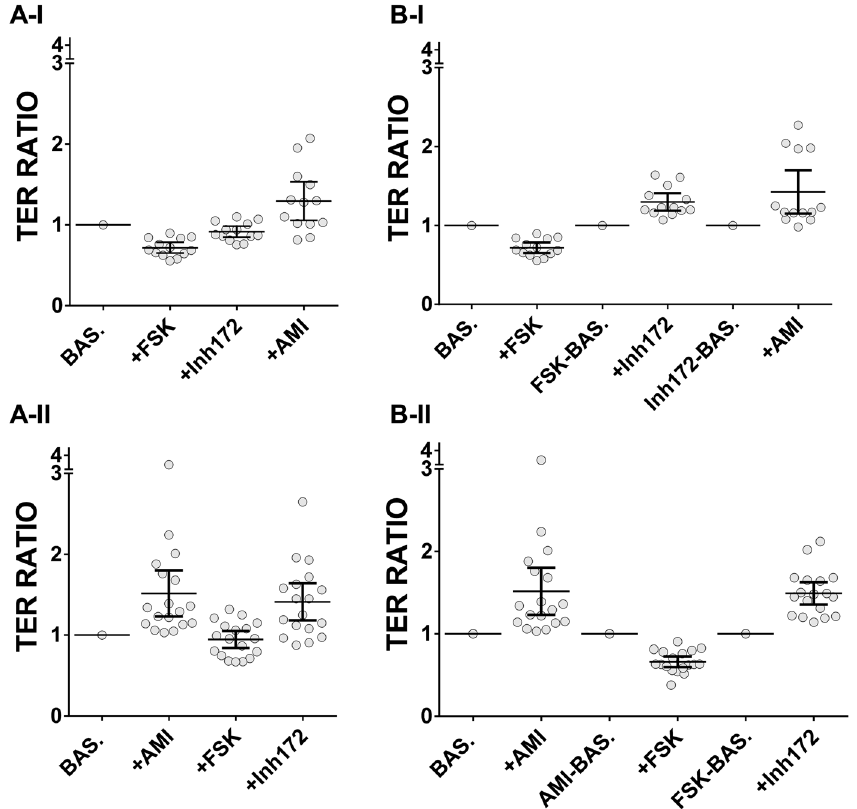
Fig 7. Donor-level analysis of TER ratio change upon drug addition. (A-I, A-II) Donors averaged ratios of TER with drug regime I (N = 13) and II (N = 18) respectively, applying the initial baseline approach highlighting the cumulative effect of the drugs. (B-I, B-II) Same data analysed applying the rolling baseline approach to the TER mean values of the individual donors. Error bars: mean ± 95%